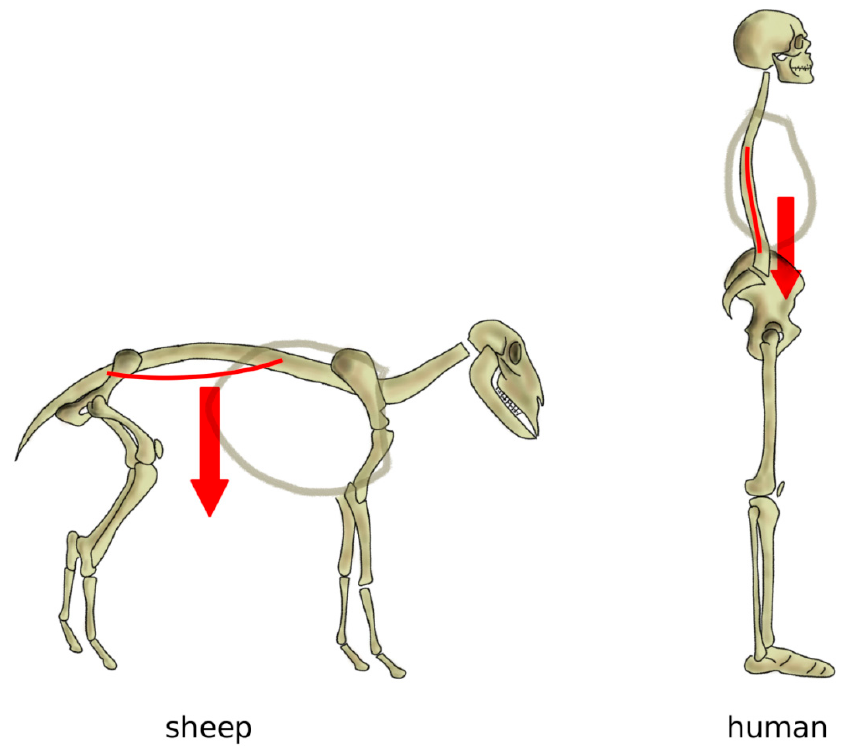
Figure 7. Simplified representation of the action of the body weight in quadrupeds (left) and in bipeds with a vertical spine (right). In quadrupeds such as the sheep, the body weight generates an extension load on the spine resulting in sag, whereas, in a vertical spine, body weight and muscles induce a mostly axial loading in compression.